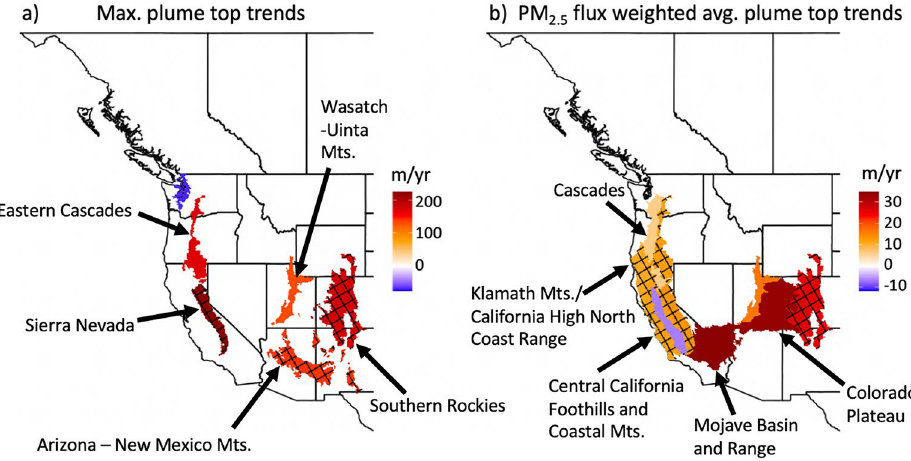
Figure 1. ( a ) Results for linear regressions trend analyses (2003–2020) of the maximum August–September plume top height for Western US ecoregions and Canadian ecoprovinces based on ~ 4.6 million plumes. ( b ) Same as ( a ), but for the PM 2.5 flux-weighted average plume top height. Only trends significant at p < 0.1 are displayed, with a crosshatch overlaid on trends with p < 0.05. Ecoregions relevant to the results presented within this manuscript are labelled. Given the similarity of trends presented in ( b ) for the Sierra Nevada, Central California Foothills and Coastal Mountains, and Klamath Mountains/California High North Coast Range ecoregions, a visual distinction may be made by viewing Fig. 2. Complete mappings of United States level 3 ecoregions 66 and Canadian ecoprovinces 67 are available from the United States Environmental Protection Agency and the Government of